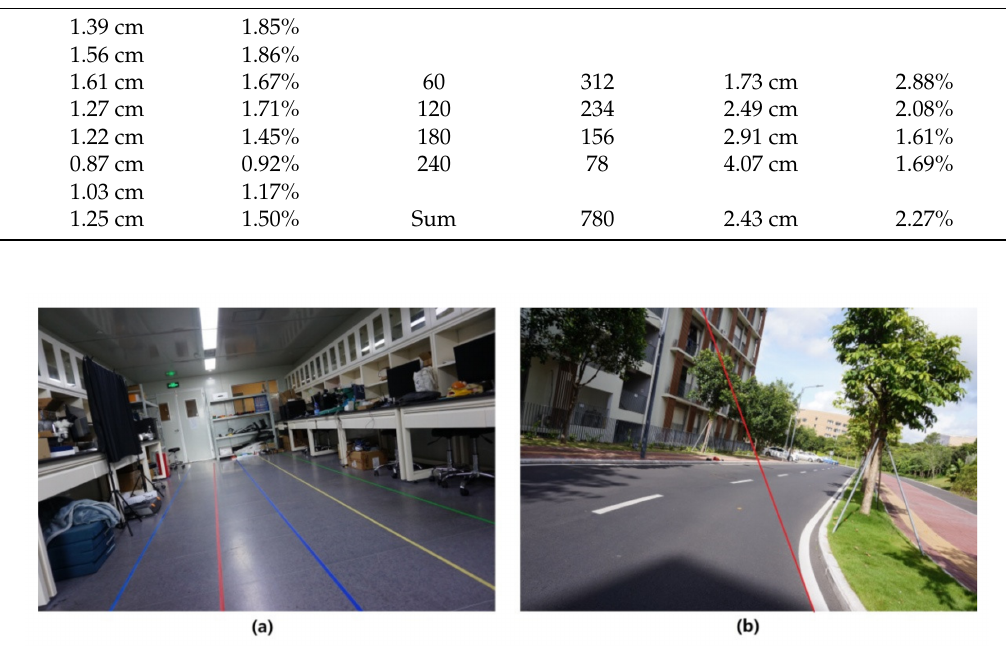
Figure 15. Example frames of the h and w’ experiment ( a ) and the curved road experiment ( b ). As for the curved roads, the tangent line of a curve plays the same role as the